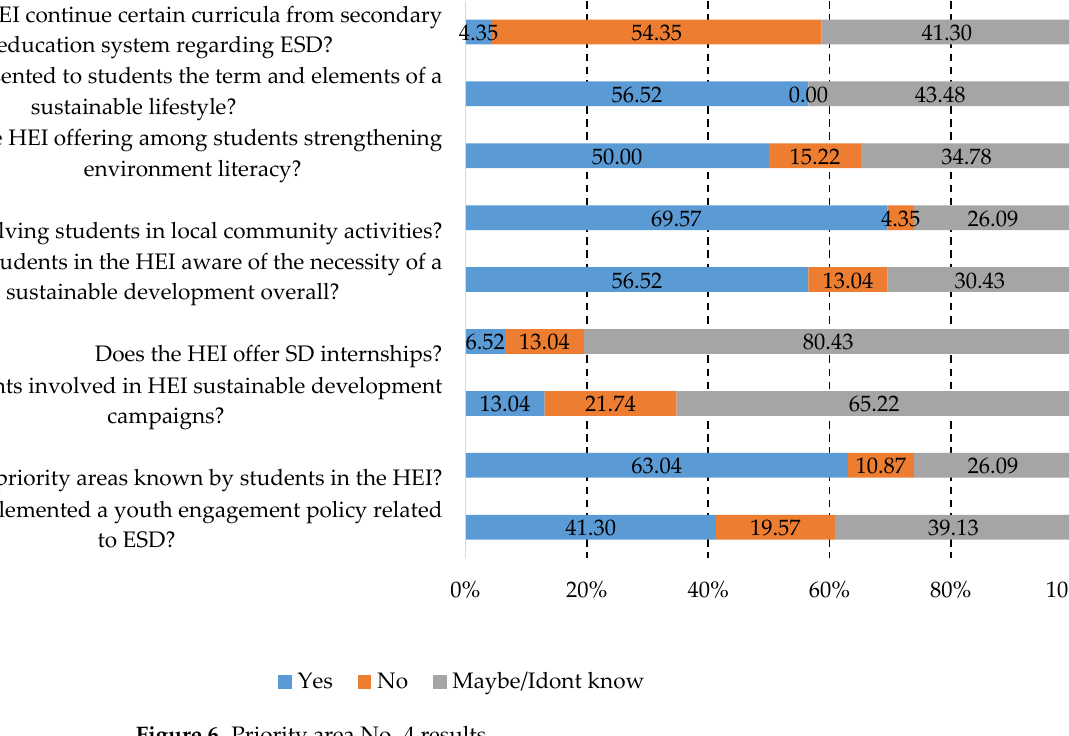
Figure 6. Priority area No. 4 results.